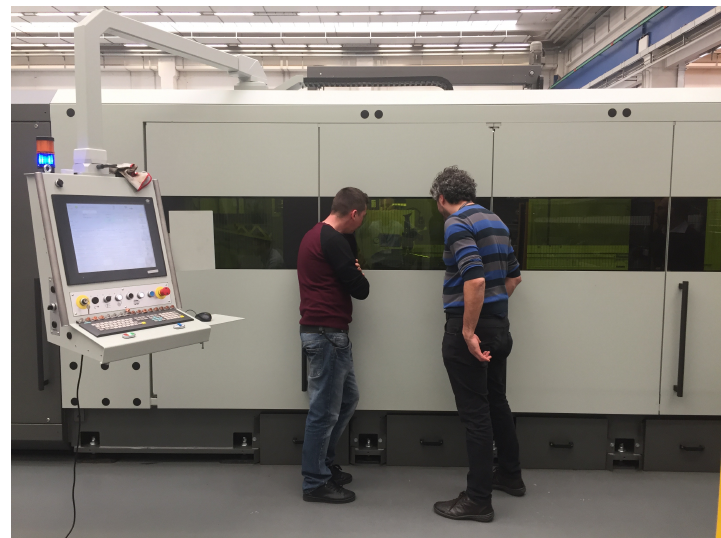
Figure 1. The LT5 Laser cutting system at ADIGE-SYS